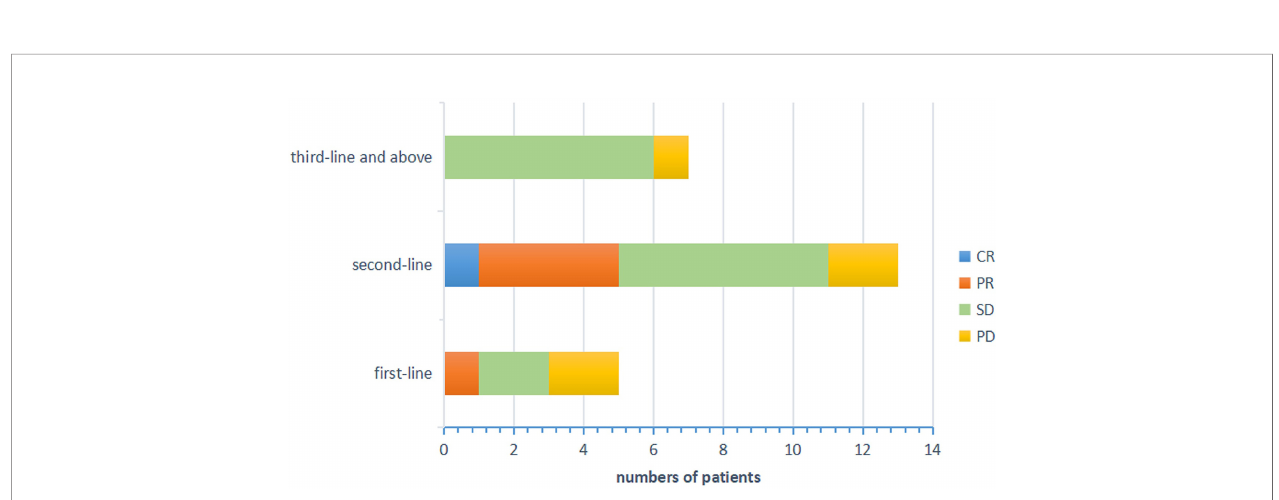
FIGURE 2 | Ef fi cacy evaluation of each treatment groups. CR, complete response; PR, partial response; SD, stable disease; PD, progressive disease.